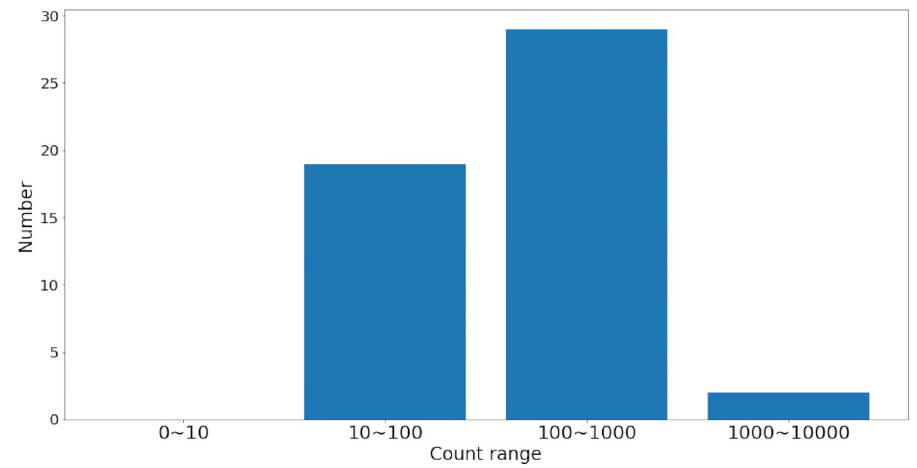
Fig 5. Histogram of maximum abundance